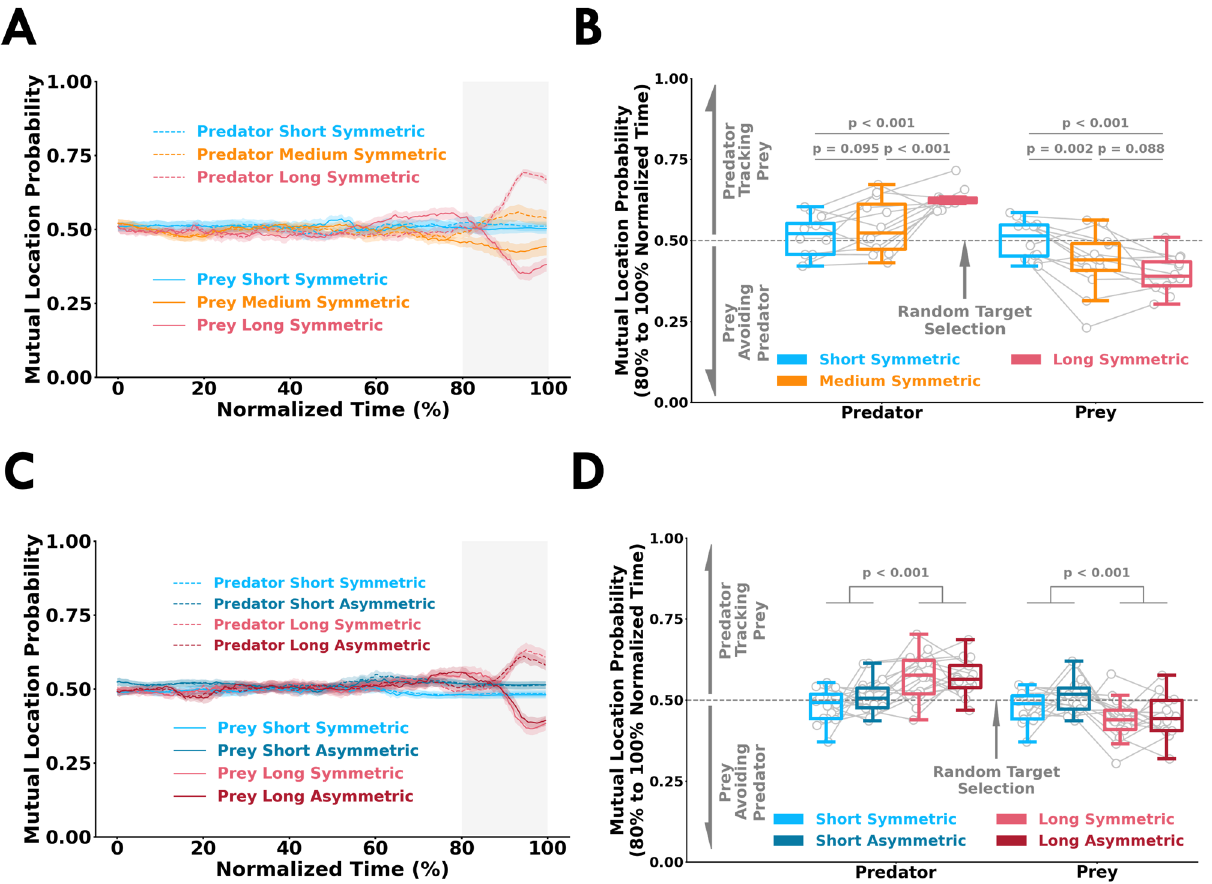
Figure 4. Tracking and avoidance behaviour. Mutual location probability ( y-axis ) across normalized time ( x-axis ) for ( A ) Experiment 1 and ( C ) Experiment 2. Average mutual location probability in the 80–100% normalized time window ( y-axis ) for each condition in ( B ) Experiment 1 and ( D ) Experiment 2. Mutual location probability greater than 0.5 or less than 0.5 represents net tracking or avoidance behaviour, respectively. Mutual location probability equal to 0.5 corresponds to random target selection (gray dashed line) and not relying on sensory evidence of an opponent’s movement. The open gray circles and connecting gray lines correspond to individual participants. Box plots show 25th, 50th, and 75th percentiles. Participants did not move in response to their opponent’s movements in the short trial conditions because they had insufficient time to utilize sensory evidence. With more available, the predator and prey respectively exhibited tracking and avoidance behaviour. Thus, with more available time, participants relied on sensory evidence of their opponent’s actions before selecting a